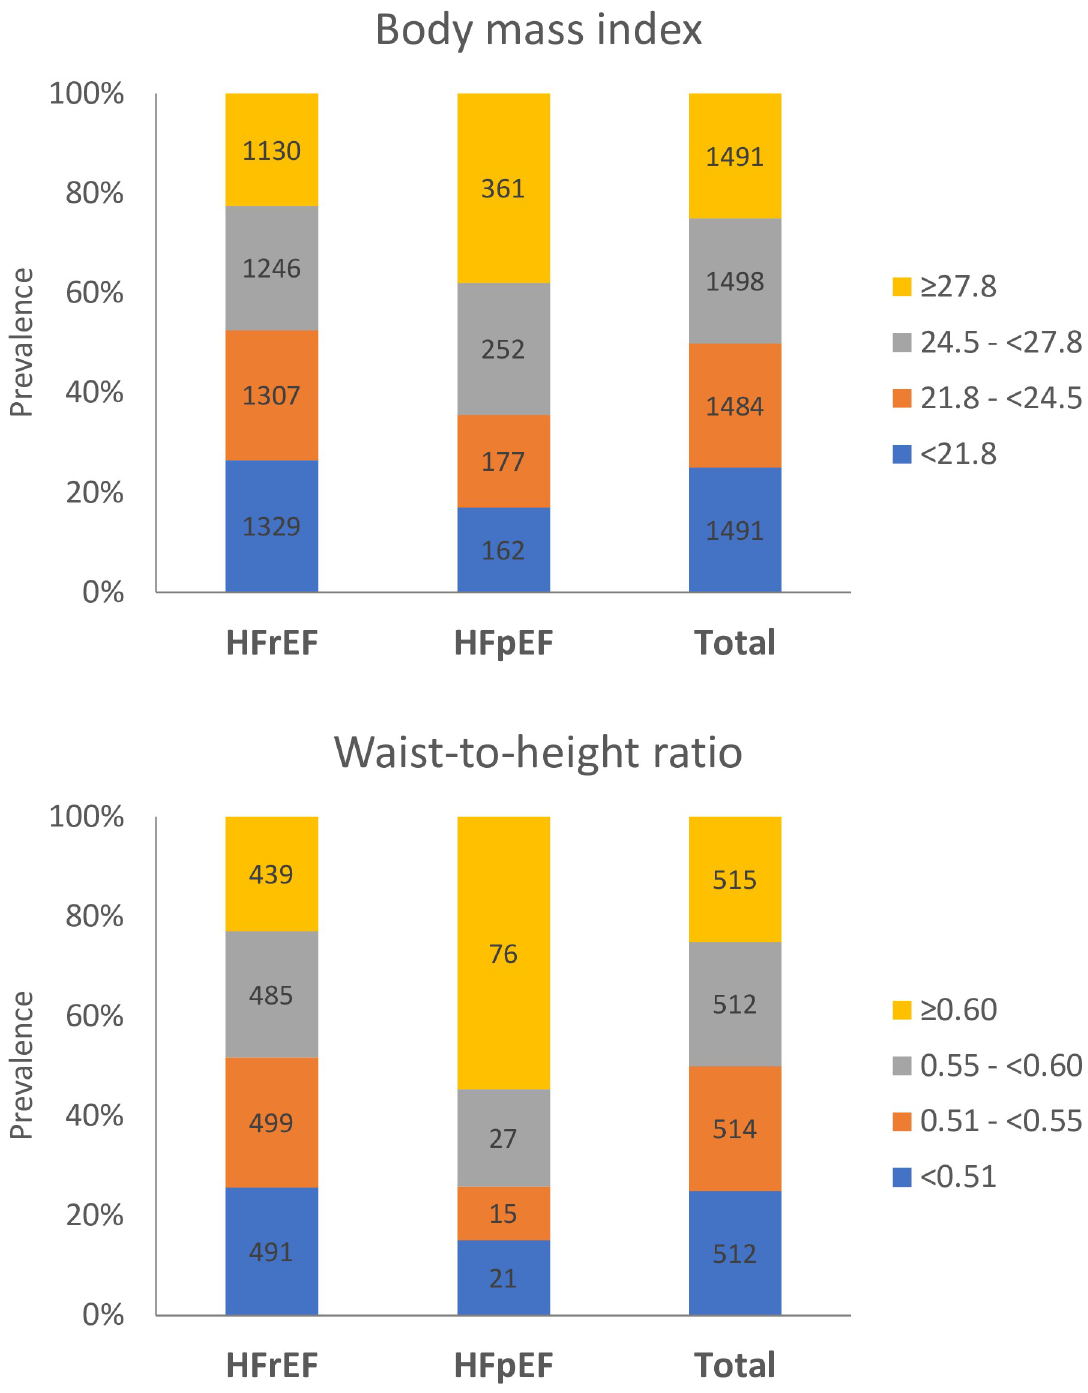
Fig 2. Prevalence of HFpEF and HFrEF stratified by body mass index and waist-to-height ratio. HFpEF, heart failure with preserved ejection fraction; HFrEF, heart failure with reduced ejection fraction.